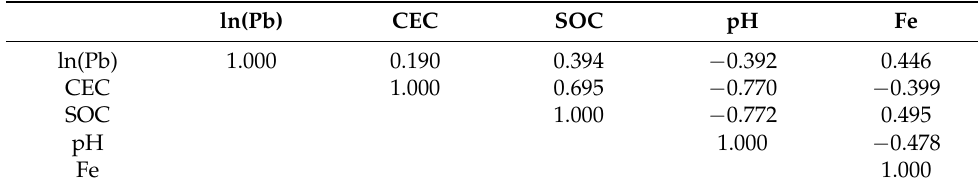
Table 4. Correlation matrix of the soil CEC, SOC, pH, Fe and measured Pb content.